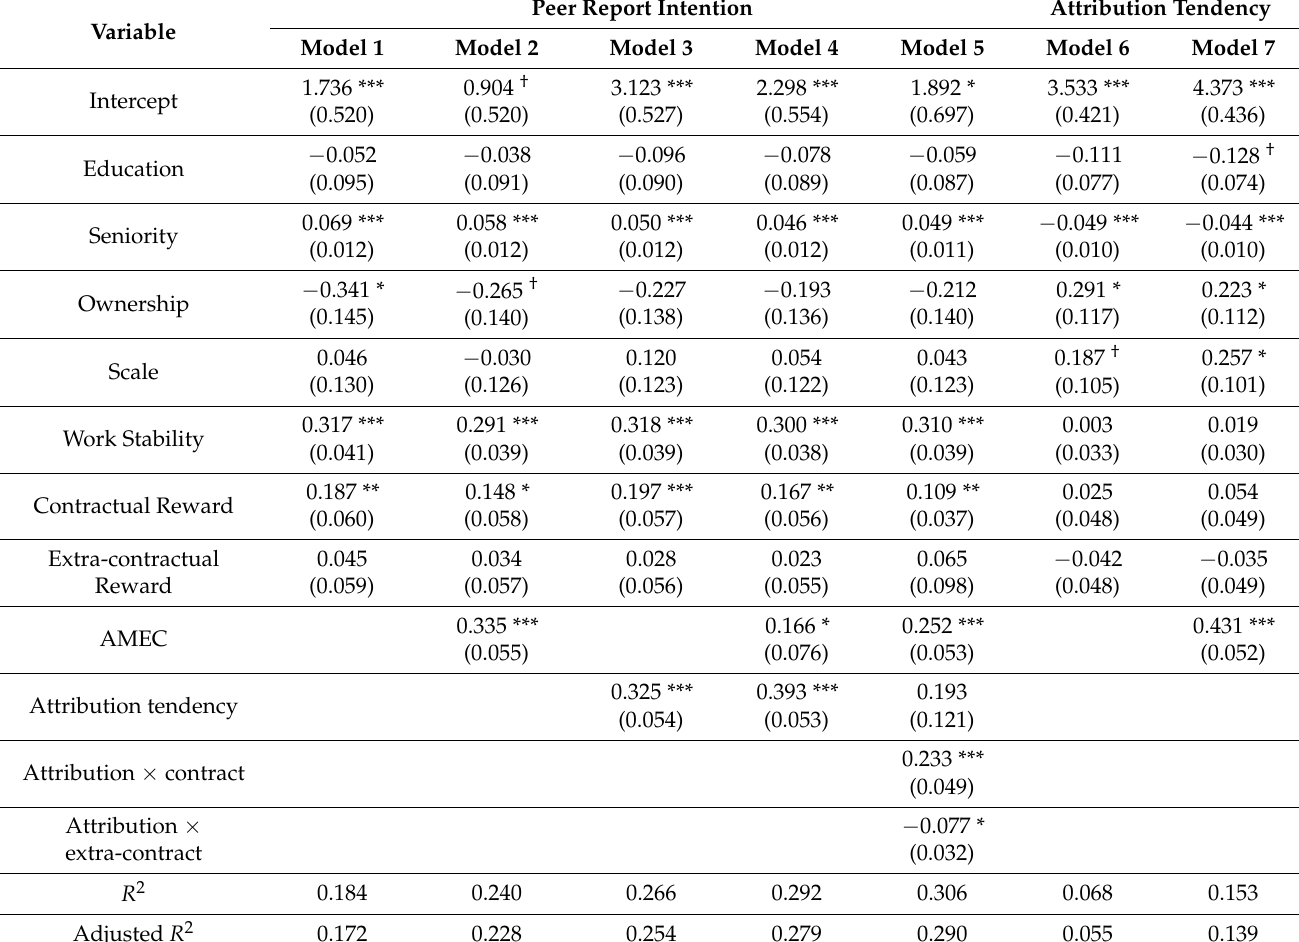
Table 3. Regression Results for Peer report intention and Attribution